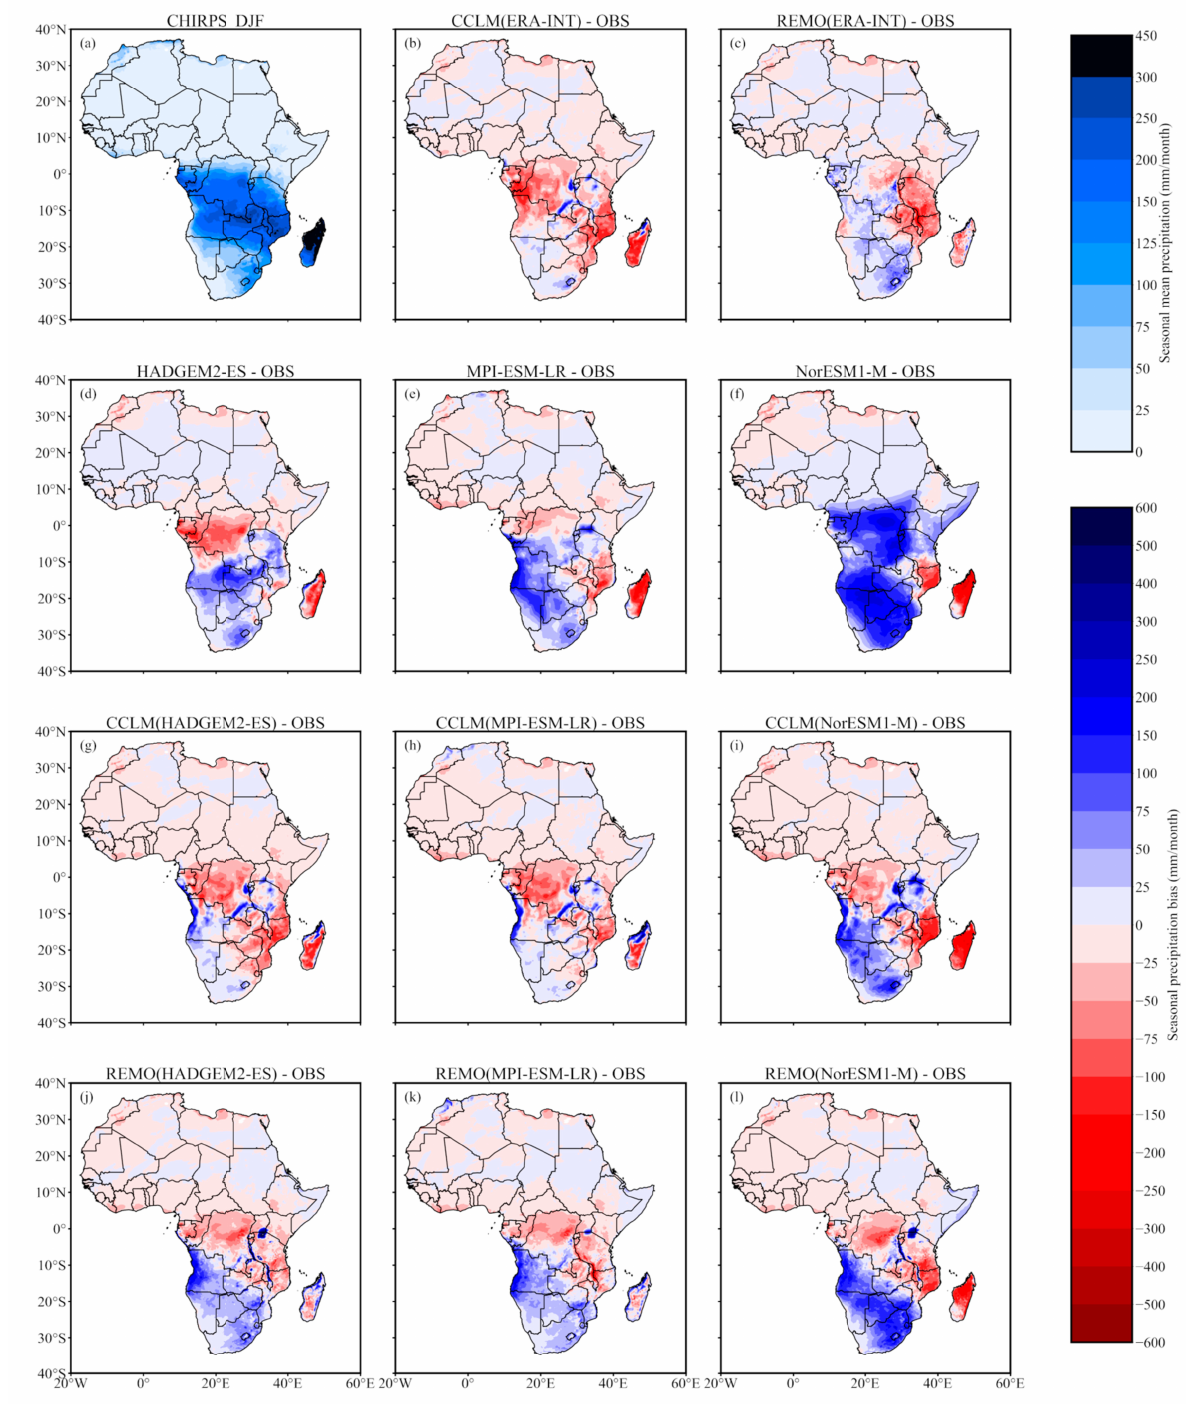
Figure 2. Bias of monthly precipitation in DJF, compared to CHIRPS, for GCMs, CCLM, and REMO: ( a ) CHIRPS ( b ) CCLM (ERA-INT)–CHIRPS, ( c ) REMO (ERA–INT)-CHIRPS, ( d ) HadGEM2–ES–CHIRPS, ( e ) MPI-ESM–LR–CHIRPS, ( f ) NorESM1– M-CHIRPS, ( g ) CCLM (HadGEM2–ES)-CHIRPS, ( h ) CCLM (MPI–ESM–LR)–CHIRPS, ( i ) CCLM (NorESM1–M)–CHIRPS, ( j ) REMO (HadGEM2–ES)–CHIRPS, ( k ) REMO (MPI–ESM–LR)–CHIRPS, ( l ) REMO